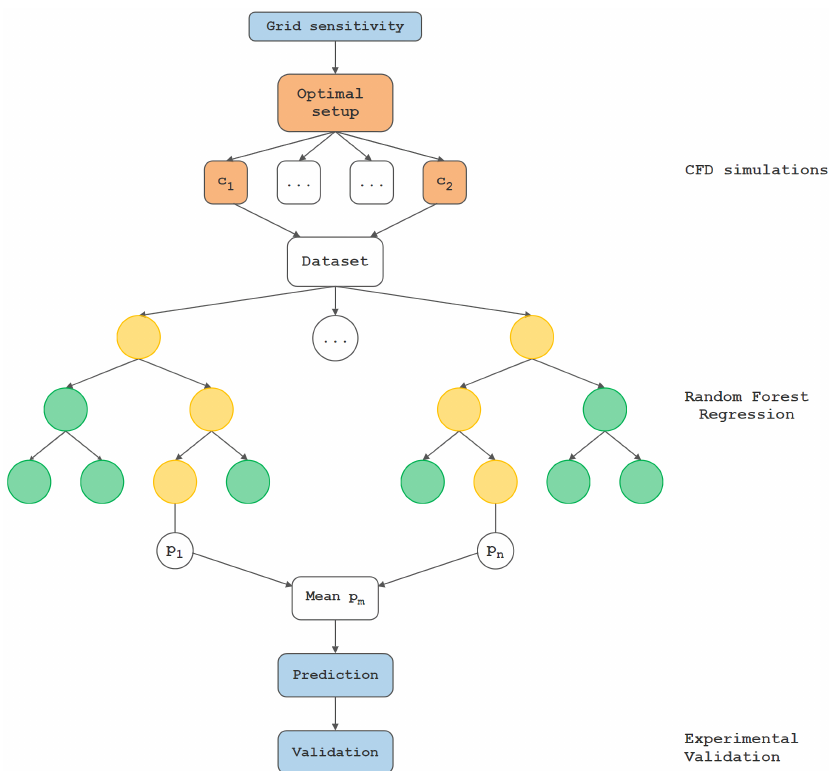
Figure 2. Proposed workflow utilizing a random forest algorithm. Numerical simulations were used to create a dataset in which relevant performance parameters and cavitation observations were